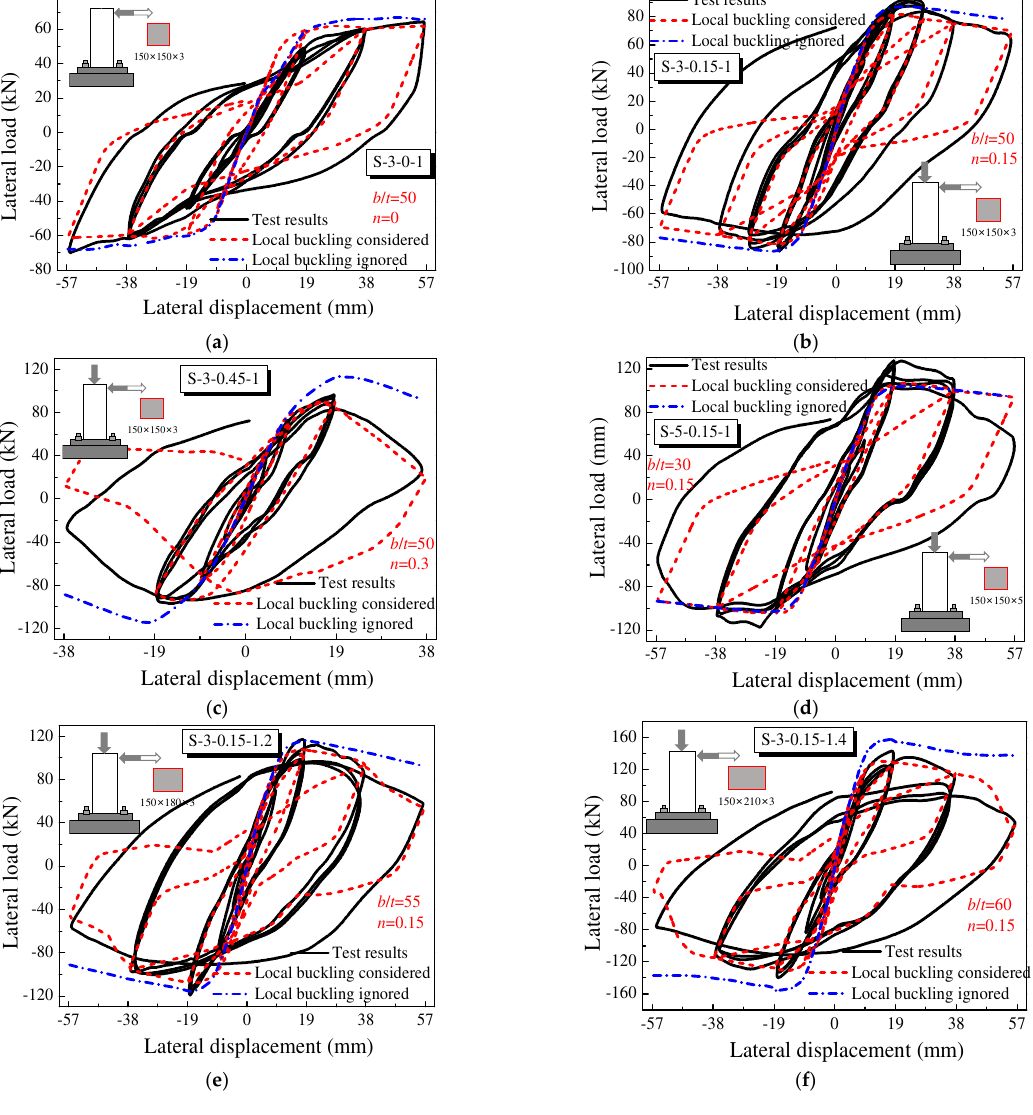
Figure 11. The comparisons of predicted P-Δ hysteretic curves with test results (Cai [38]). ( a ) As shown in Figure 11d–f, n remained at a constant value of 0.15. It was found that for specimen S-5-0.15-1 with a width-to-thickness ratio of 30, local buckling had no signif- icant effects. However, as b/t increased to 55 and 60, neglecting the local buckling also overestimated the peak load and post-peak ductility of the UHPCFST columns, which led to insecurity in the seismic design of structures. It was noted that there were some devia- tions in the unloading and reloading branches between the predicted results and test re- sults, which were closely related to the pinched characteristics of the Clough model. On the whole, the axial compression ratio ( n ) and width-to-thickness ratio ( b / t ) are the most important factors affecting the local buckling of members. On the one hand, the increase in the axial load significantly increased the stress levels; on the other hand, the critical stress for local buckling was significantly reduced with the increase in the width- to-thickness ratio.